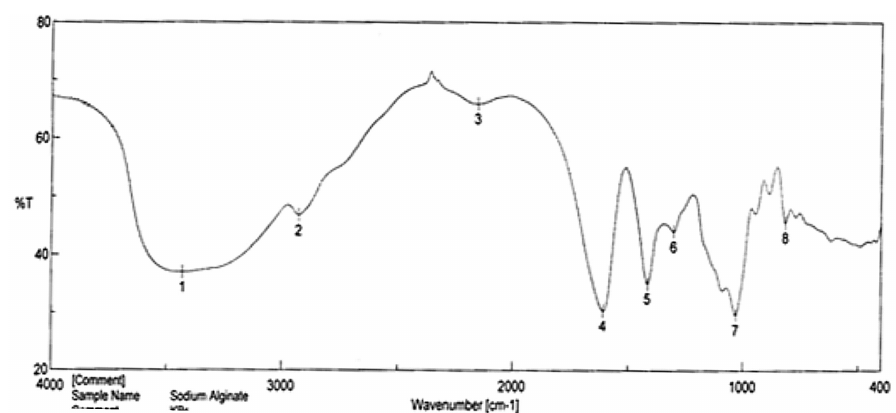
FIGURE 7 (b) - FTIR Spectroscopic analysis of sodium alginate alone.